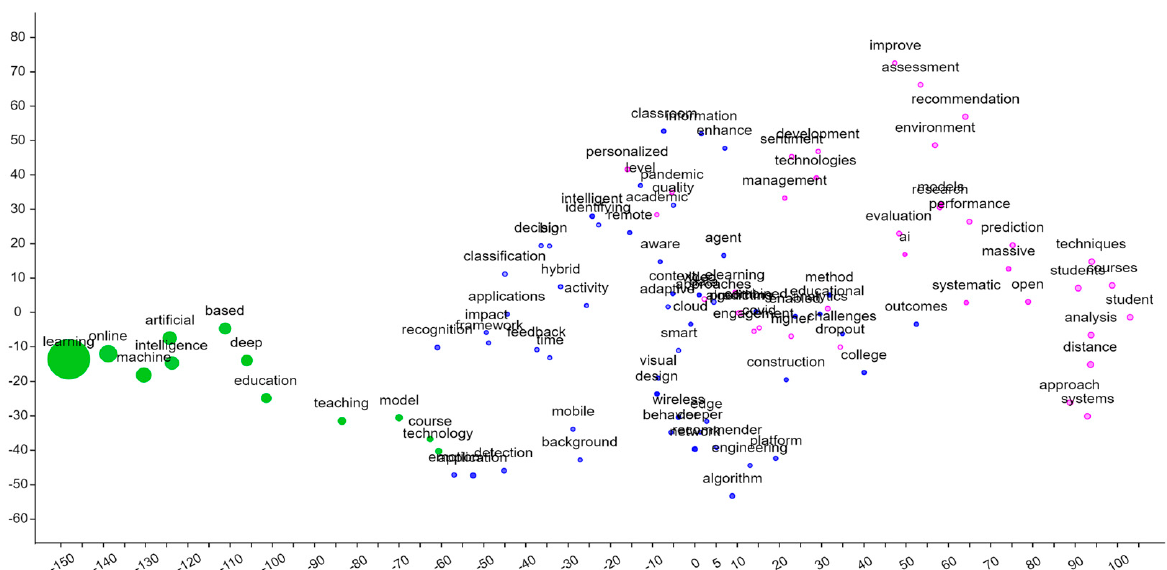
Figure 3. Subject areas of the publications on AI in online distance education (one publication can be coded for more than one subject area).